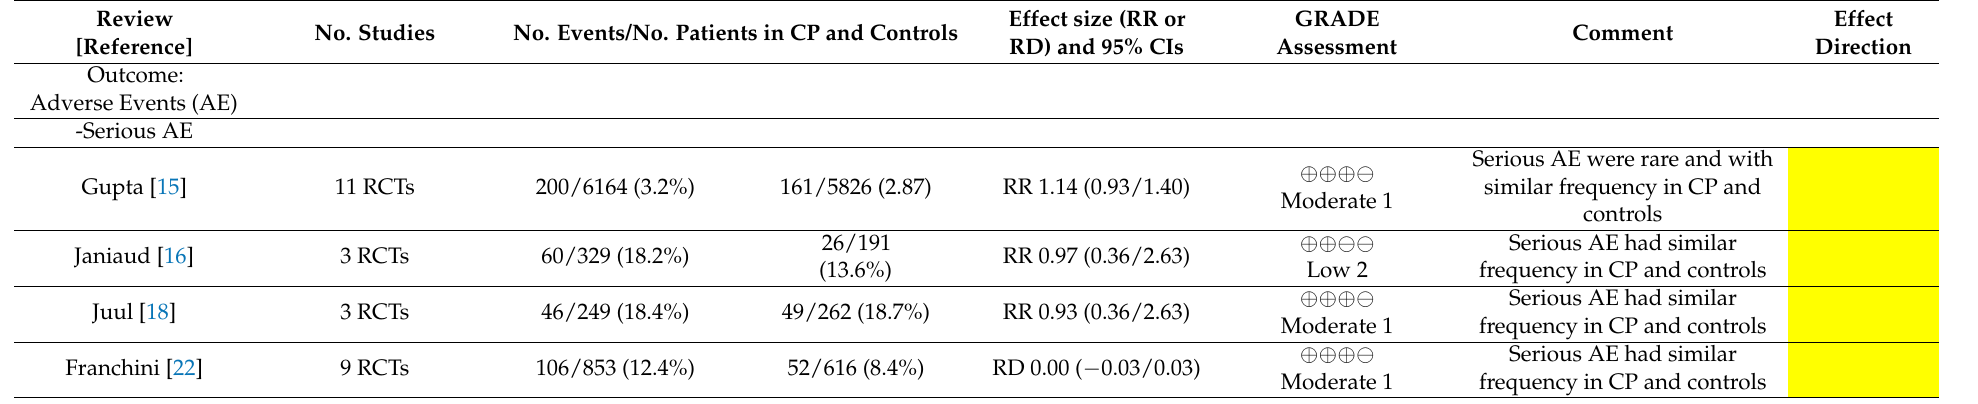
Table 5. Adverse reactions related to convalescent plasma